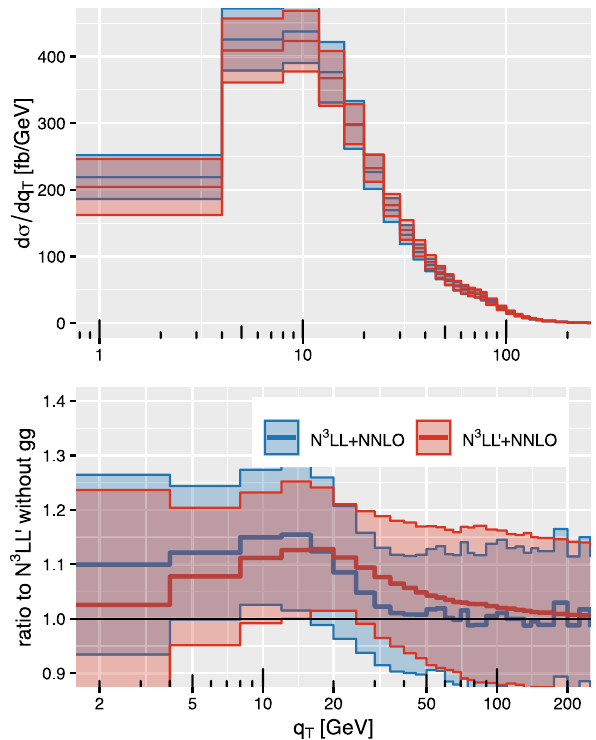
Fig. 4 Fully matched q T spectra at N 3 LL + NNLO and N 3 LL (cid:2) + NNLO. Top plot: absolute distributions. Bottom plot: ratio to N 3 LL (cid:2) + NNLO without gg channel